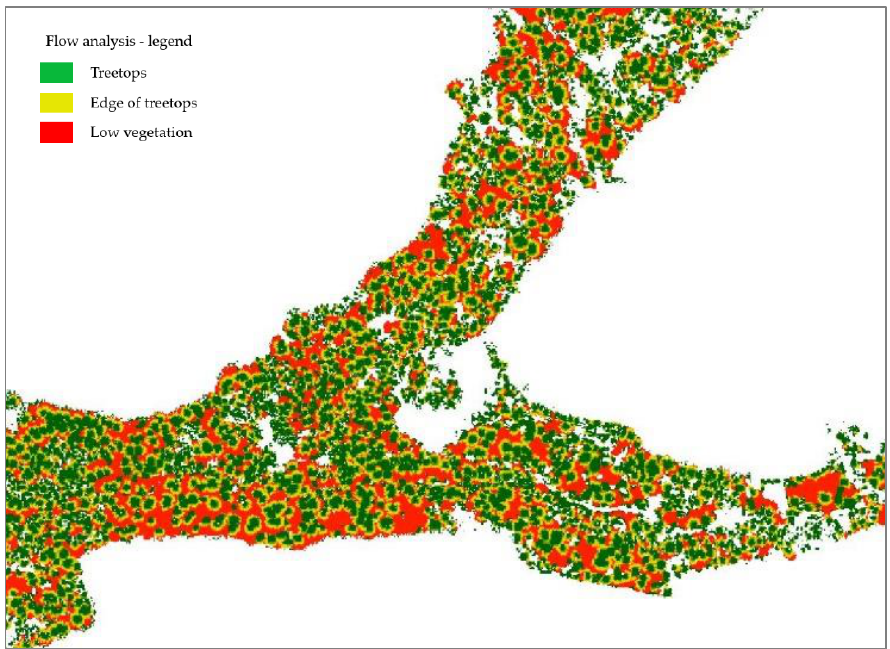
Figure 2. Processing of Digital Surface Model (DSM) based data in the Forest Bačetín with ArcGIS tools Flow analysis, processed and highlighted treetops (green)—the direct method to identify individual trees. Displayed area 600 × 500 m.